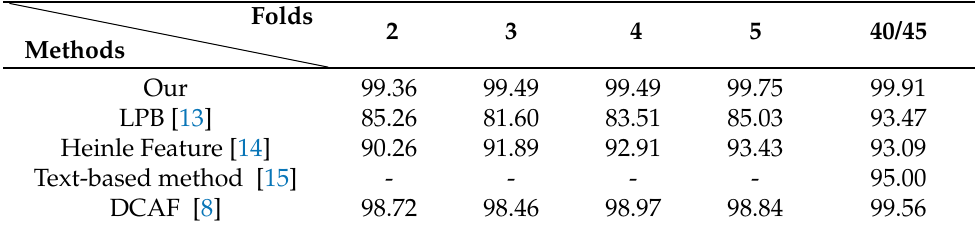
Table 7. Experimental results on SWIMCAT